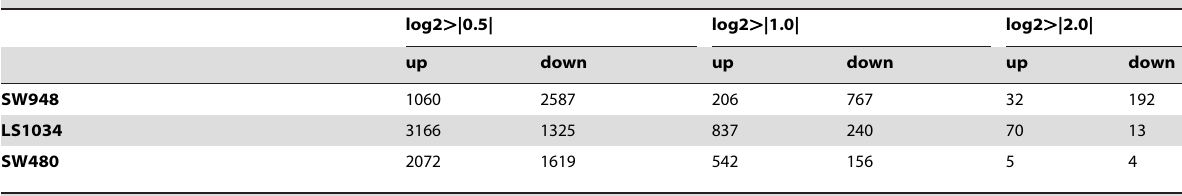
Table 1. Colon cancer cells depleted from KRT23 compared to control